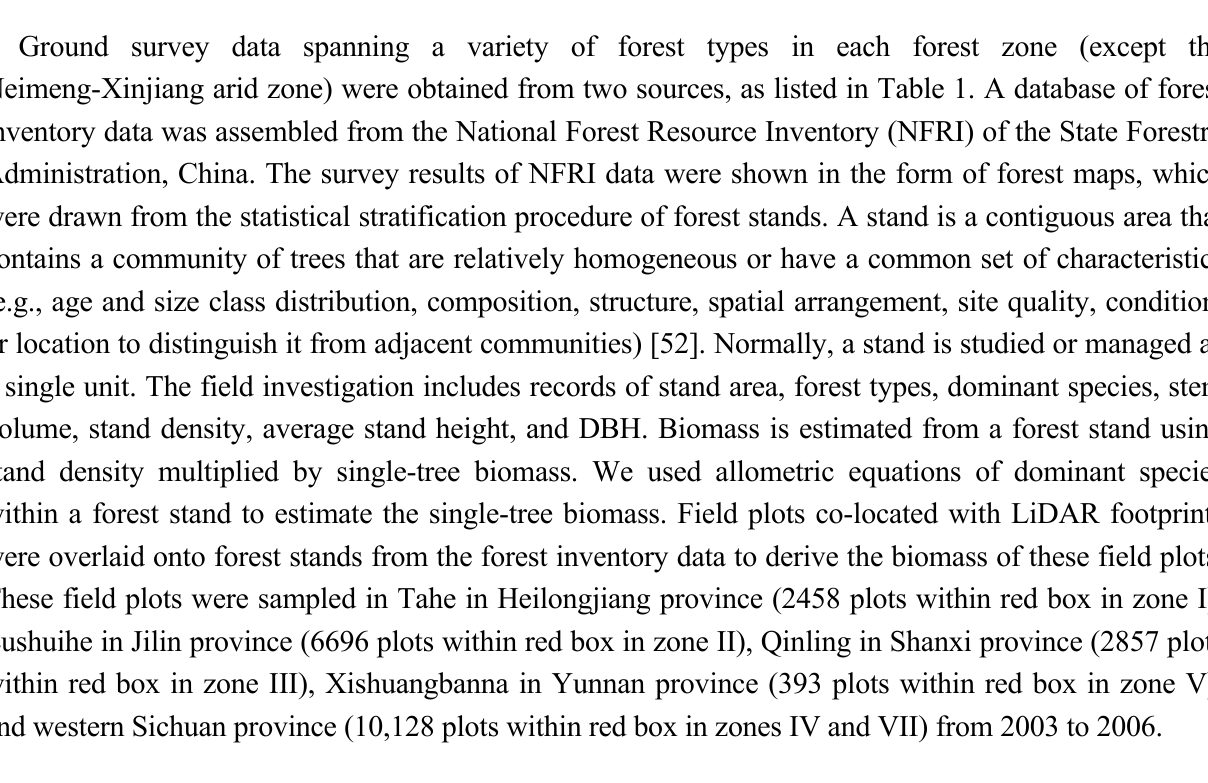
Table 1. Summary of field data. N t is the total number of all field forest stands and N n , N b , and N m are the total number of needleleaf forest, broadleaf forest, and mixed forest stands, respectively. Ns is the number of field data listed by source and acquisition